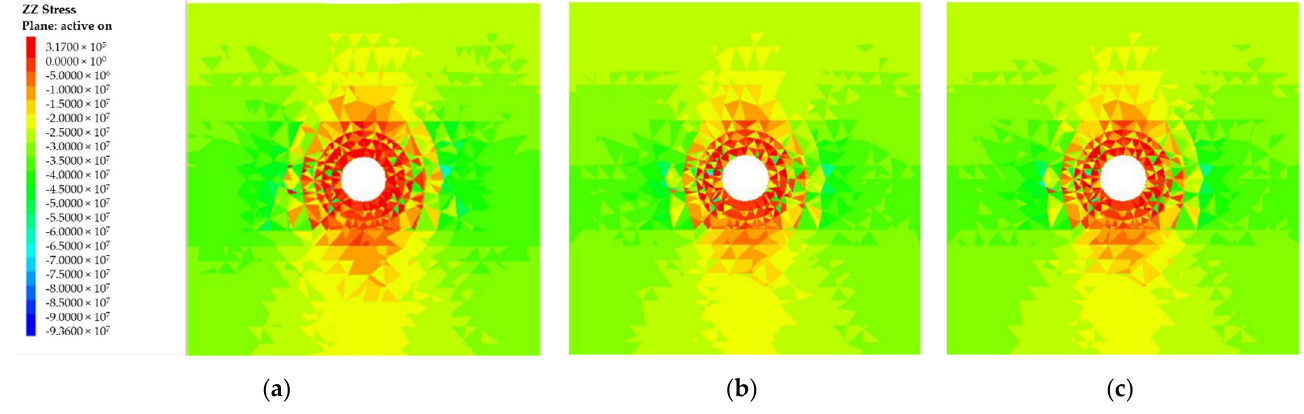
Figure 7. Vertical stress distributions of the rock mass around the tunnel of support face: ( a ) unsup- ported, ( b ) radial support, and ( c ) non − radial support.